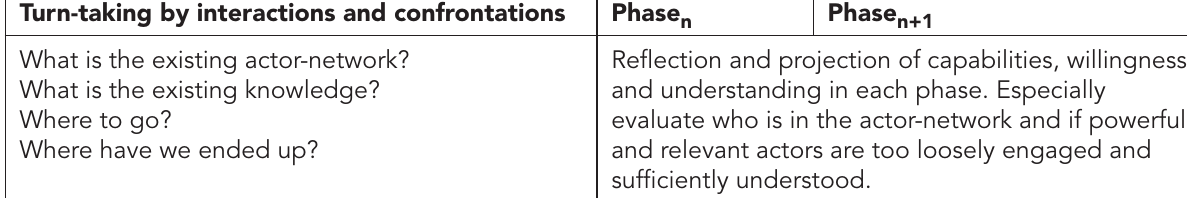
Table I: Open analytical model for projection and